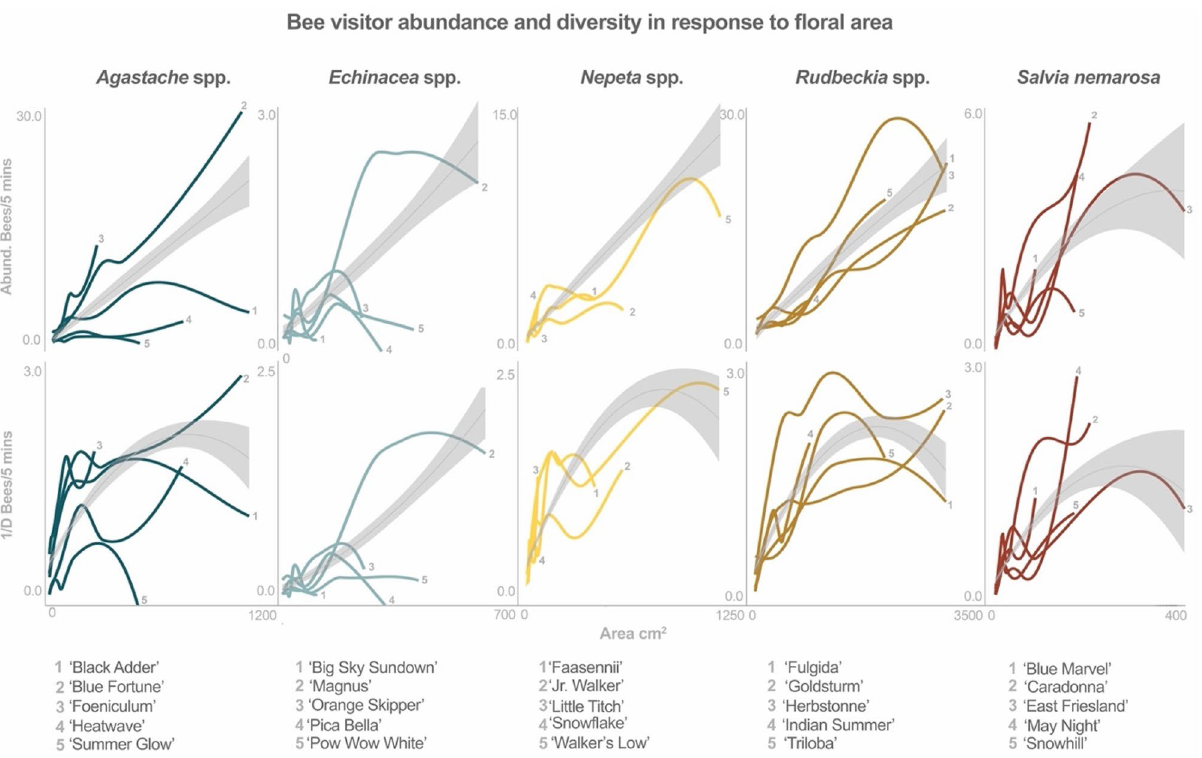
Figure 4. Cultivars are fit to a ’loess’ regression while genera (overlaid in grey) are fit to a second order polynomial regression. For most cultivars, visitor abundance increases linearly with larger floral area while visitor diversity plateaus or decreases before peak bloom.